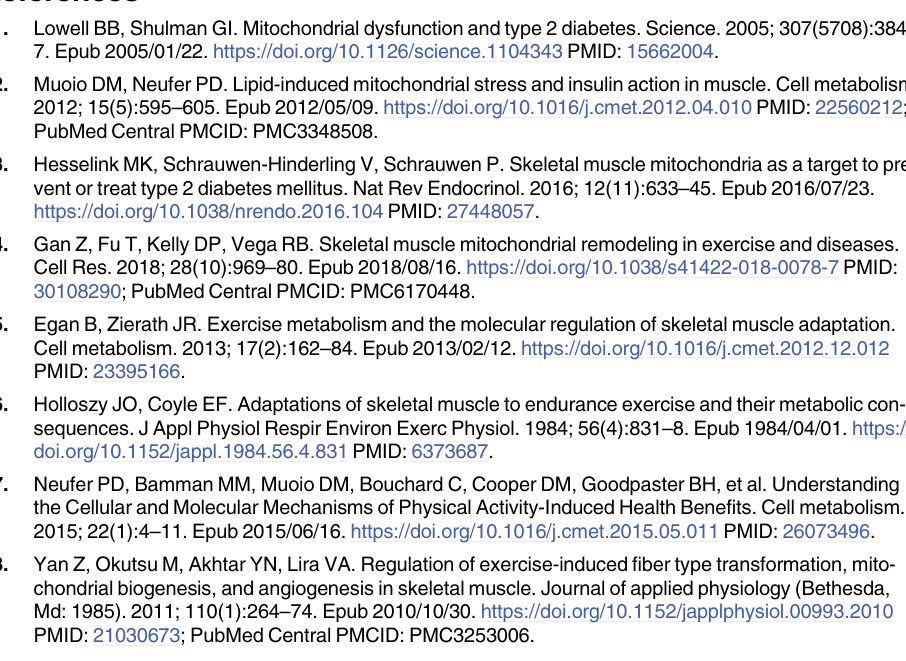
S3 Table. sgRNA for Fnip1 knockout mice generation. S4 Table. RT-PCR